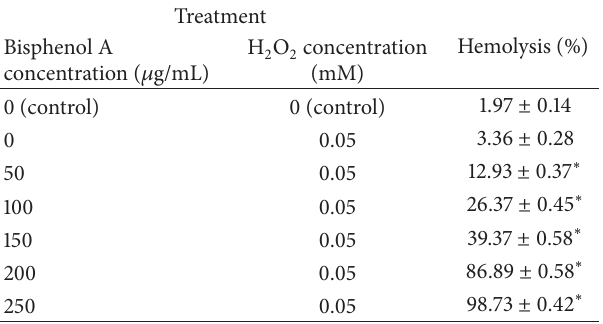
Table 4: Bisphenol A induced hemolysis along with cotreatment of